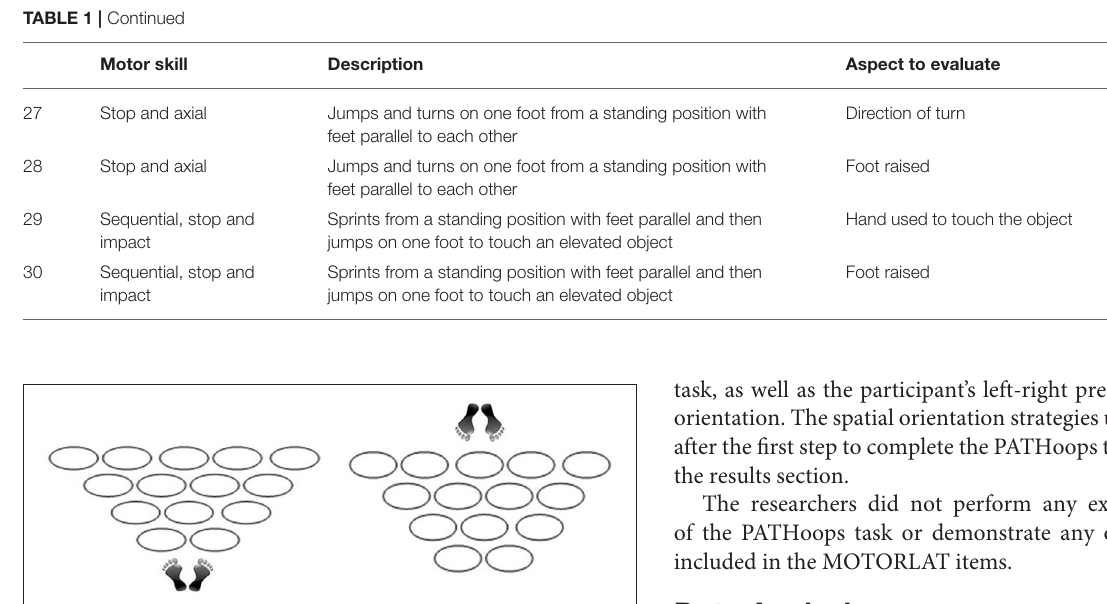
FIGURE 2 | (Left) Starting position from the narrow side of PATHoops. (Right) Starting position from the wide side of PATHoops.